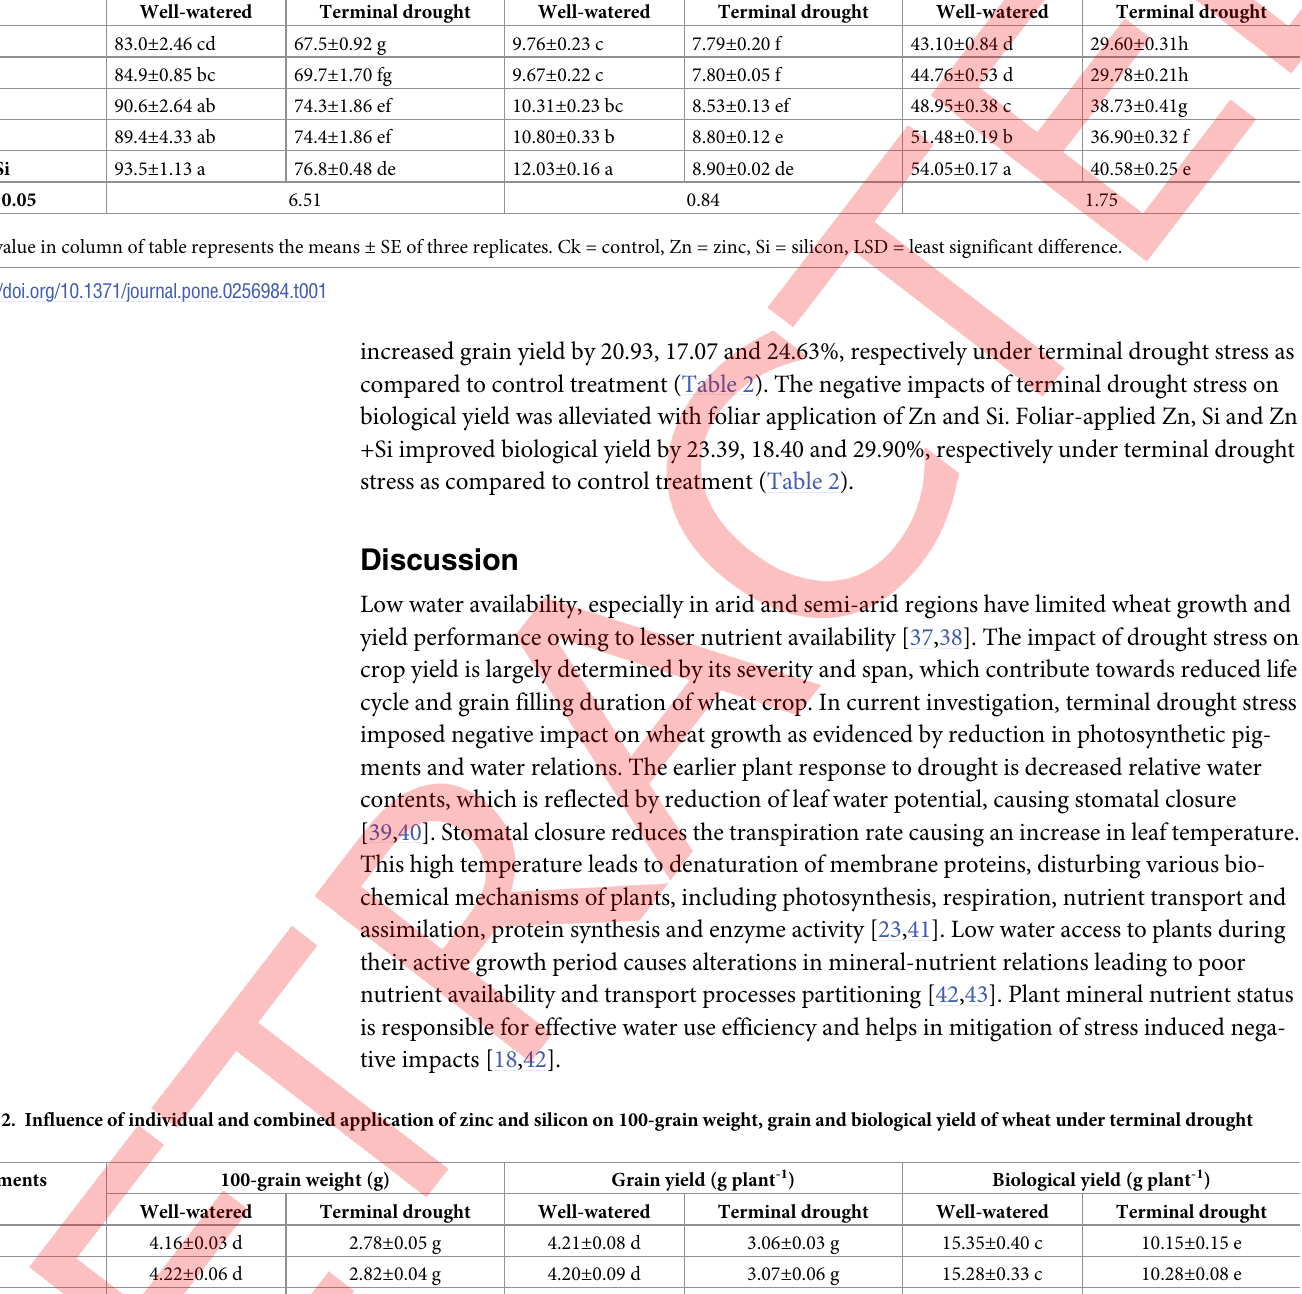
Table 1. Influence of individual and combined application of zinc and silicon on plant height, spike length and number of grains per spike of wheat under drought stress conditions. Treatments